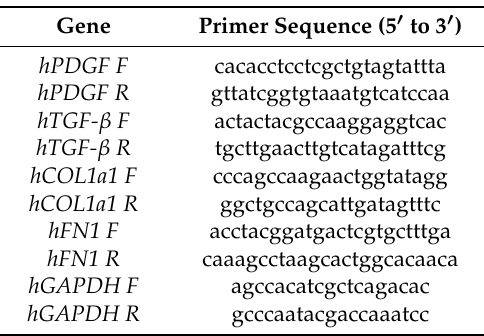
Table 1. List of primer sequences for real-time